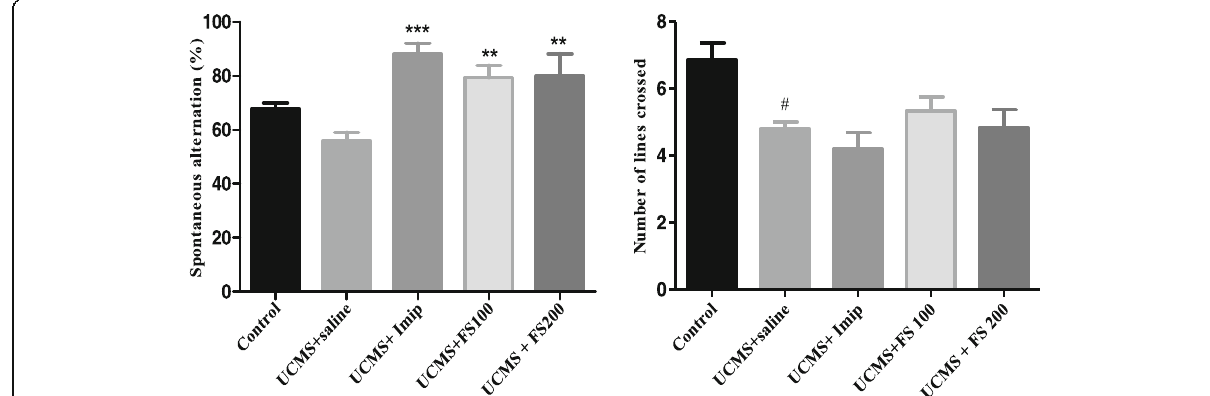
Fig. 11 Effect of the hydromethanolic extract of F. sycomorus on the percentage of spontaneous alternation and on locomotor activity of rats in the Y-maze. TNn=normal witness; TNg =negative witness; Imip=imipramine. ** P<0.01; * p<0.05 vs. TNn; γ p<0.05 vs.